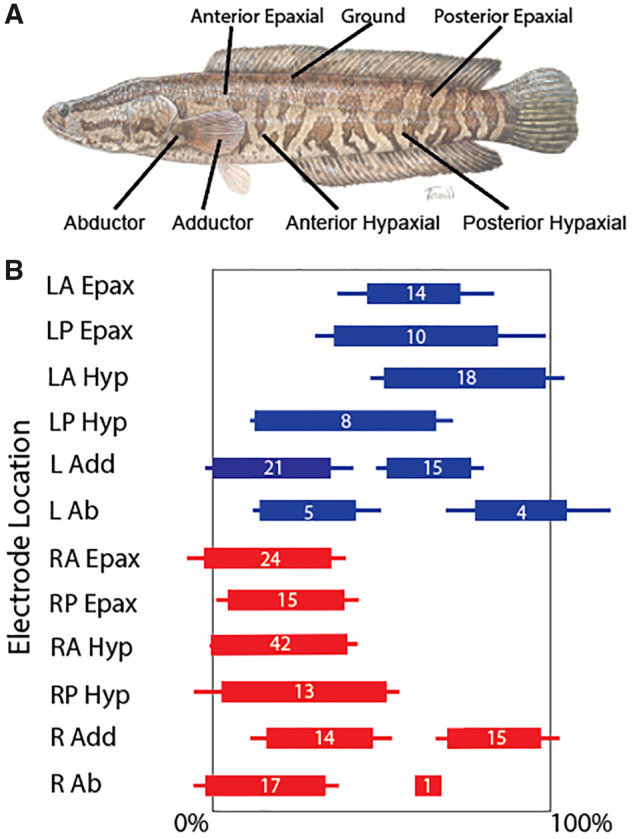
Muscle activity pattern during the terrestrial forward crawl of northern snakeheads. (A) Each northern snakehead (n = 7) in the EMG experiments had six intramuscular fine-wire electrodes implanted on each side (blue = left, red = right) in the labeled muscles, as well as a ground electrode near the base of the dorsal fin (snakehead image by Susan Trammell). (B) Since their forward crawl is a cyclical behavior, the muscle activity pattern is shown from 0% to 100% for each stride, with 100% being 0% of the subsequent stride. The thick bars indicate the average start and end times of muscle activation, while the thin bars reflect the standard error (SE). The numbers on the thick bars show the number of strides recorded for each muscle, with two numbers present for the abductors and adductors because these muscles would activate up to two times per stride. Overall, there is a left–right activation pattern of axial muscles, while both pectoral fins are coordinated for each half of a stride. The RA Hyp was chosen as the starting frame of reference as it had the most strides recorded of any muscle. LA Epax, left anterior epaxials; LP Epax, left posterior epaxials; LA Hyp, left anterior hypaxials; LP Hyp, left posterior hypaxials; L Add, left adductor; L Ab, left abductor; RA Epax, right anterior epaxials; RP Epax, right posterior epaxials; RA Hyp, right anterior hypaxials; RP Hyp, right posterior hypaxials; R Add, right adductor; R Ab, right abductor.